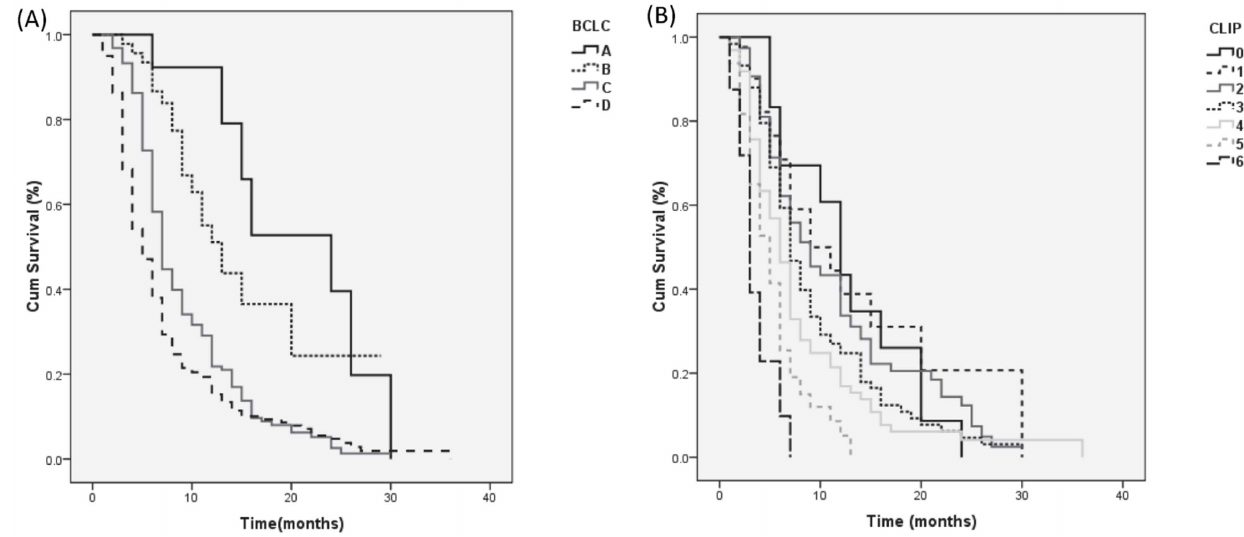
Figure 3. Survival curves for patients not amenable to treatment. Probability of survival for patients not amenable to treatment according to (A) CLIP score, (B) BCLC staging system.